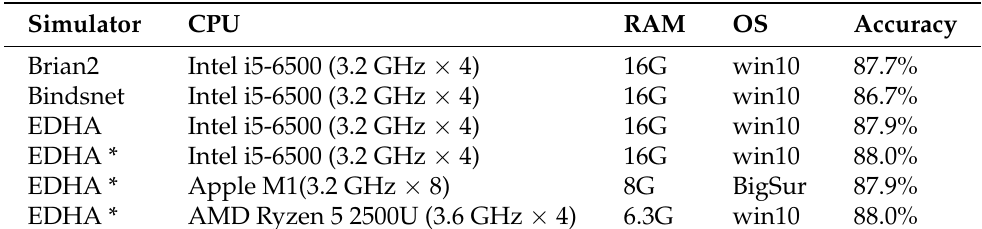
Table 5. Time required for EDHA and Brian2 to run on the MNIST unsupervised model. EDHA with asterisk is that EDHA ran the optimized model.